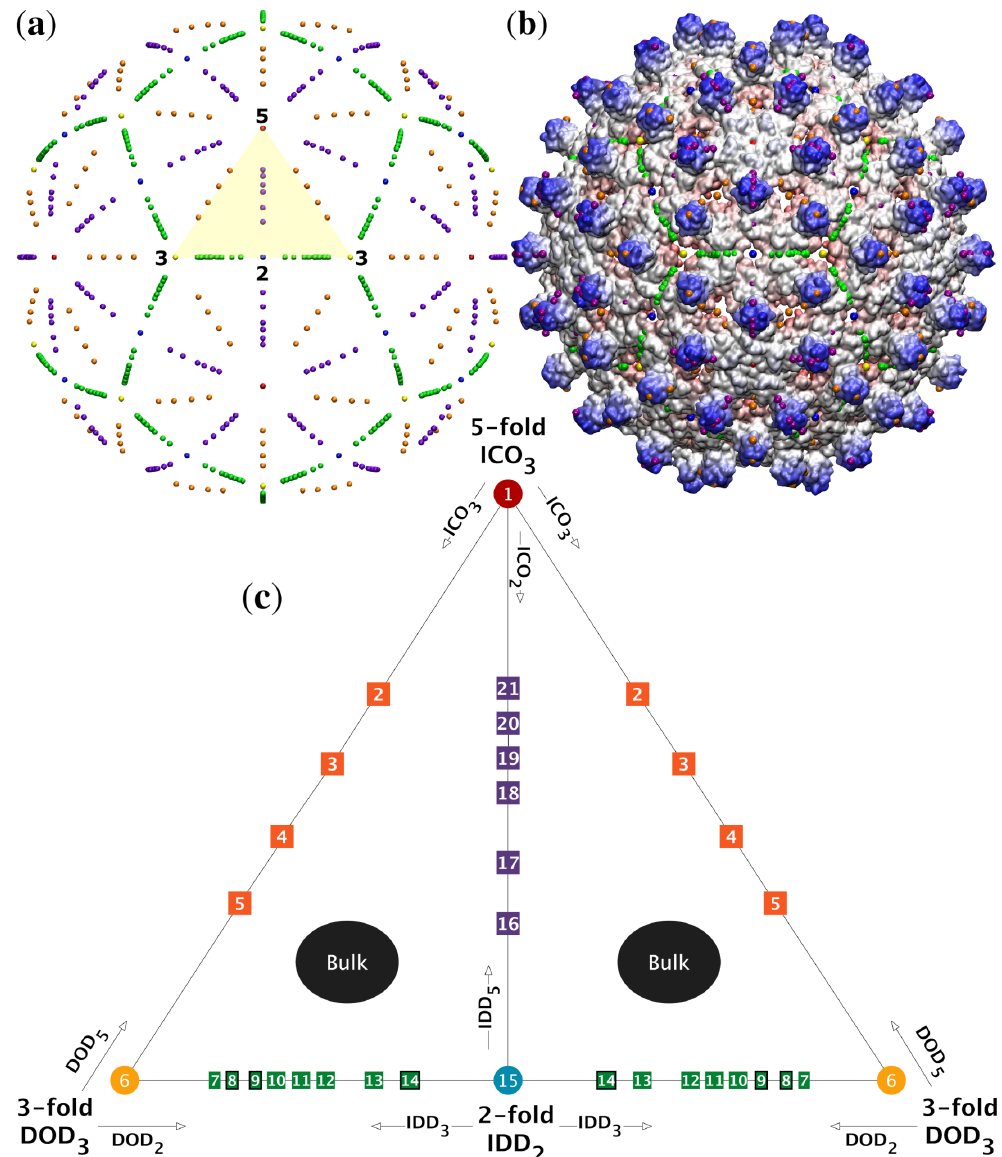
Figure 1. ( a ) The spatial distributions of gauge points have icosahedral symmetry, i.e., they are arranged with 2-, 3- and 5-fold symmetry as shown. The gauge points all lie on the 15 icosahedral great circles which connect nearest neighbor symmetry axes [4] and are colored as in Table 1. We refer to the arcs of the circles subtending the 2-, 3- and 5-fold axes as the 5-2 GC, 5-3 GC and 2-3 GC. The volume bounded between these arcs is known as the asymmetric unit (AU) and is a representative one-sixtieth section of the entire capsid (yellow). ( b ) The gauge points have been placed on a radially colored HBV (1qgt) capsid at their nearest possible distance from the protein surface. We will later see that the only admissible gauge points are the purple and orange elements sitting atop the protruding dimers. ( c ) There are 21 unique gauge points in the AU, see Table 2. The gauge points are formed from 2-, 3- and 5-fold translations of the icosahedron (ICO), Dodecahedron (DOD) and Icosadodecahedron (IDD). The gauge points along the 2-, 3- and 5-fold axes result solely from IDD 2 , DOD 3 and ICO 5 point arrays, respectively. The off-axis gauge points, e.g., GP:2-GP:5, each result from only nearly identical point arrays known as sister point arrays. For example, Gauge Point 4 (GP:4) is only created from φ (cid:48) ICO 3 and φ DOD 5 . In total 36 of the 55-point arrays have gauge points off-axis. There are no gauge points in the bulk regions not located on the great circles, however interior points of the point arrays can be located